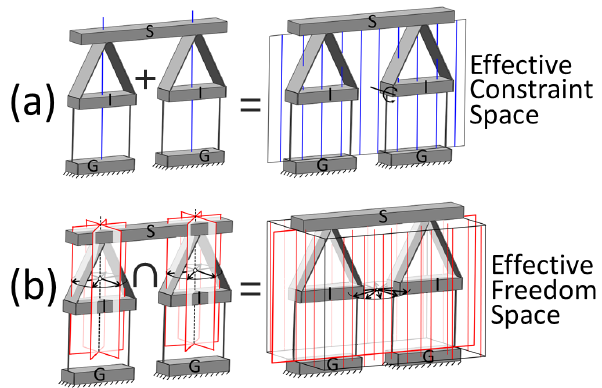
Figure 10. Linearly combine the constraint spaces of limbs (a) or find the intersection of their freedom spaces (b) to find a hybrid system’s complementary freedom and constraint spaces.